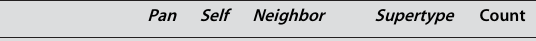
(A) Predictors of HLA-A locus molecules (with random negatives) Pan Self Neighbor Performance values for the ‘‘leave-one-out’’ experiment with added random negatives. (A) shows the performance for the 24 HLA-A alleles, and (B) the performance for the 18 HLA-B alleles. The first column gives the allele name, the following columns the performance of the Pan, Self, Neighbor , and Supertype methods, respectively, as explained in the text. After the Neighbor and Supertype performance values is shown the neighbor allele name and supertype association, respectively. Note, that the supertype performance is only stated for the non-supertype representing alleles. The final column gives the number